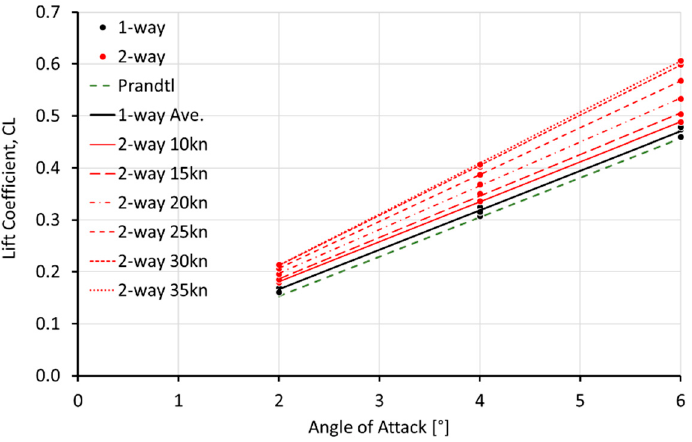
Figure 13. Lift coefficient vs. base chord AoA.